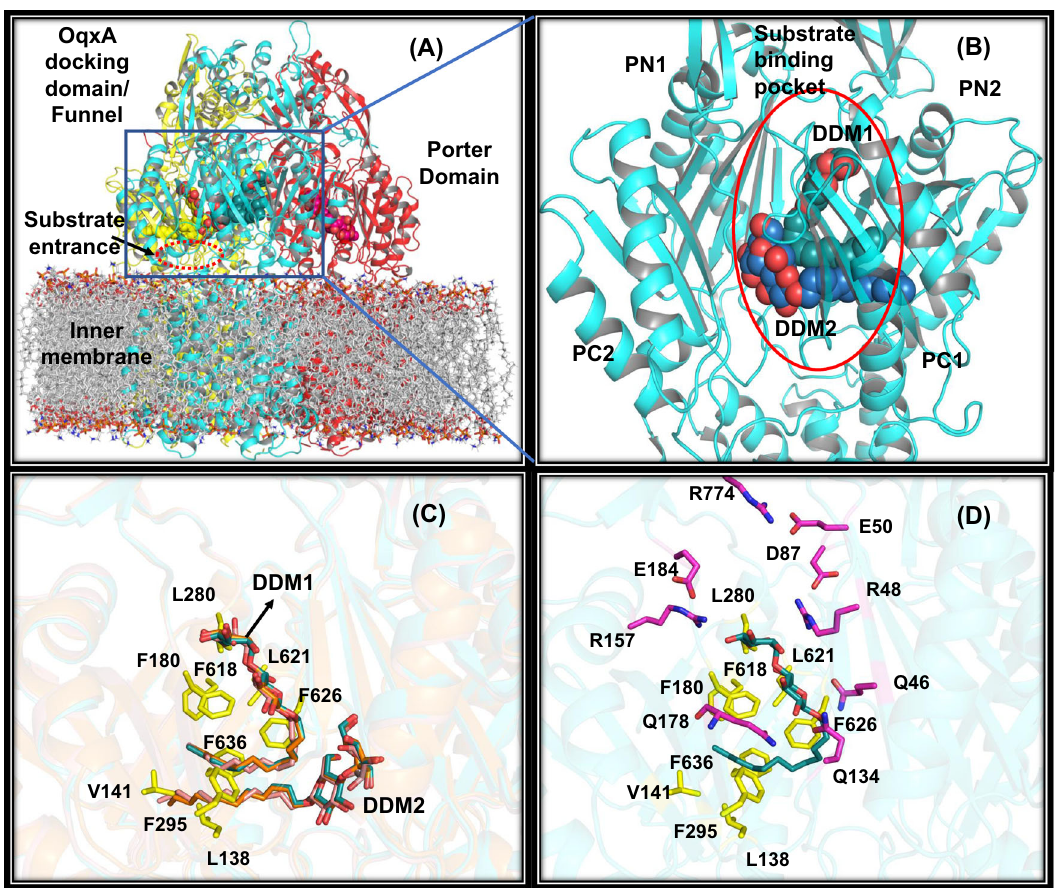
Fig. 2 OqxB substrate-binding pocket. The OqxB trimer is shown with a bilayer membrane model ( A ). The individual protomers are highlighted with red, cyan, and yellow color cartoons. The substrate-binding pocket with two DDM ligand molecules ( B ) is shown in one of the protomers. The DDM1 and DDM2 molecules are shown as cyan and blue colors spheres, respectively. The identical binding orientations of DDM1 and DDM2 molecules ( C ) in three individual protomers of OqxB trimer. The hydrophobic residues of the substrate-binding pocket are highlighted as yellow sticks and labeled. The hydrophilic (magenta sticks), as well as hydrophobic (yellow sticks) residues of substrate-binding pocket ( D ). DDM1 molecule shown as cyan